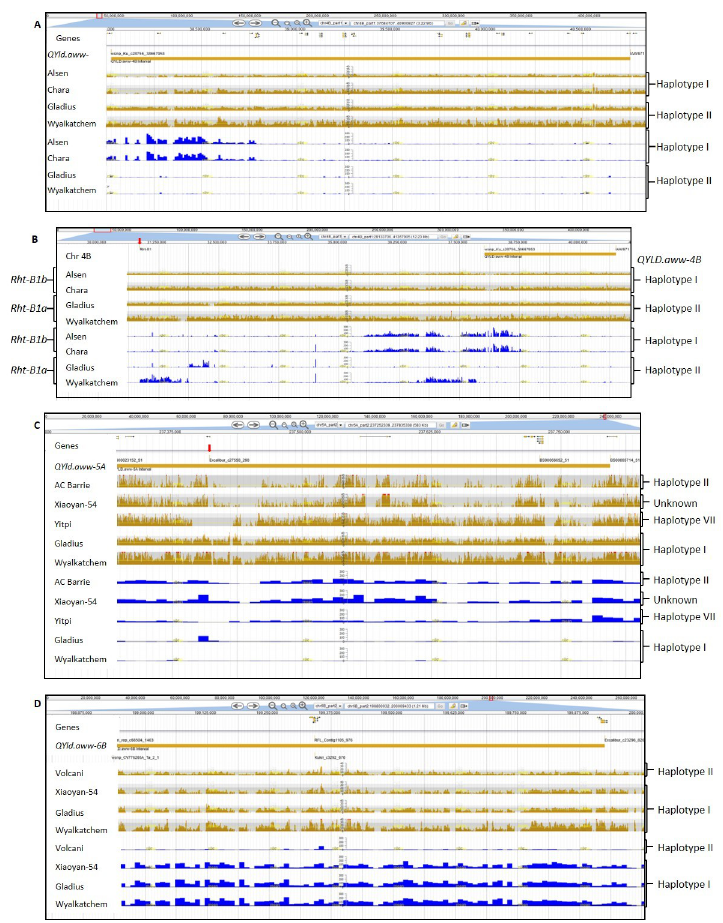
Fig 3. DAWN screenshot of the three yield QTL regions aligned to Chinese Spring reference sequence, RefSeq v1.0. The “Genes” track shows the high confidence genes according to the RefSeq annotation v 1.0. The yellow tracks show the number of reads from a wheat accession that aligns to RefSeq v1.0 at each position of the genome. The blue tracks show the variant density (SNP per 10 Kb–log scaled) between reads from a wheat accession and RefSeq v1.0. (A) The “ QYld . aww-4B ” track shows the QTL interval and the position of the significantly associated markers. (B) –The “Chr4B” track shows the region on chromosome 4B containing QYld . aww-4B and Rht-B1 . Different patterns across the blue tracks in the QYld . aww-4B and Rht-B1 regions indicate that these two regions segregate independently. (C) – The “ QYld . aww-5A ” track shows the QTL interval and significantly associated markers. The red arrow indicates the region of the marker Excalibur_c27558_298. (D) –The “ QYld . aww-6B ” track shows the QTL interval and the significantly associated